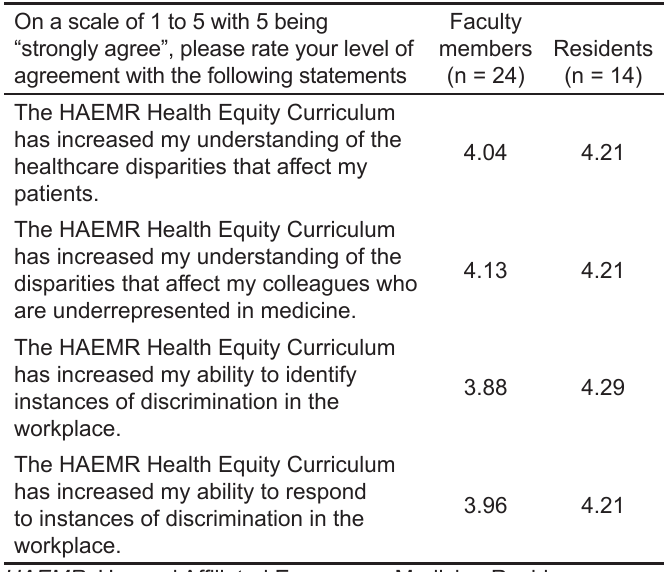
Table 2. Average Satisfaction Scores on 6-month